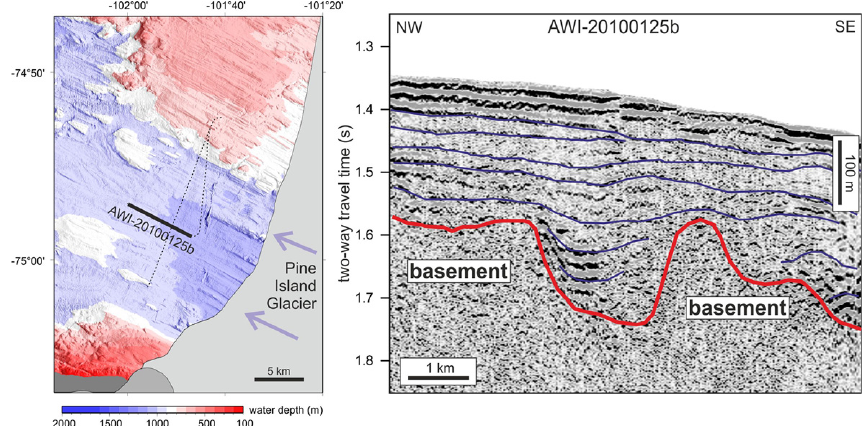
Fig. 6. Seismic profile (bold solid line) recording a sedimentary basin of at least 300m thickness off the ice shelf edge of Pine Island Glacier. Dotted lines mark other seismic profiles. Blue lines in seismic section mark a set of horizons within the sedimentary strata. The vertical scale bar is based on an estimated seismic velocity of 2000ms − 1 in the sediments. See Fig. 2 for